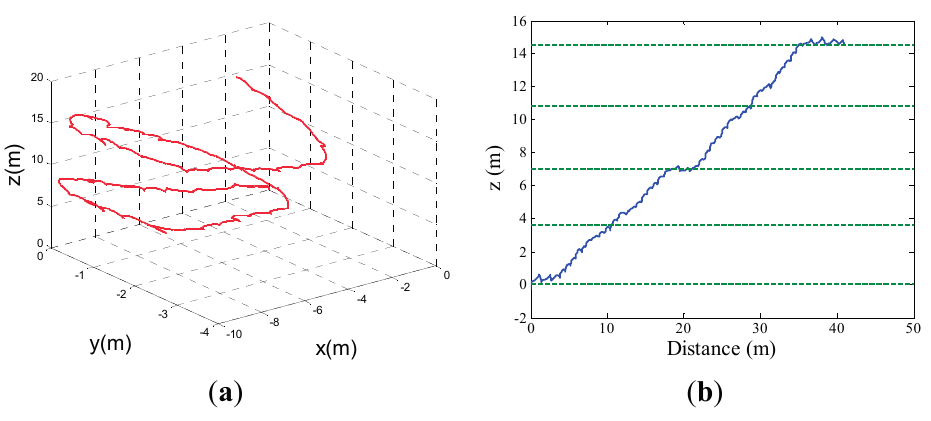
Figure 17. ( a ) Estimated 3D path for going upstairs; ( b ) Estimated